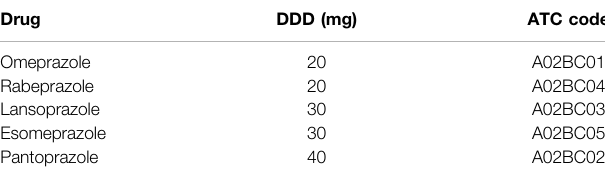
TABLE 3 | Proton pump inhibitors available in our hospital. Drug